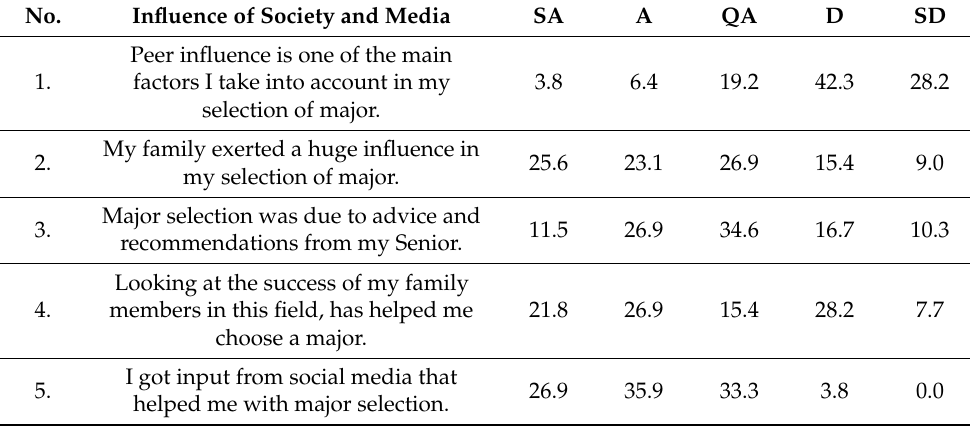
Table 4. Influence of Society and